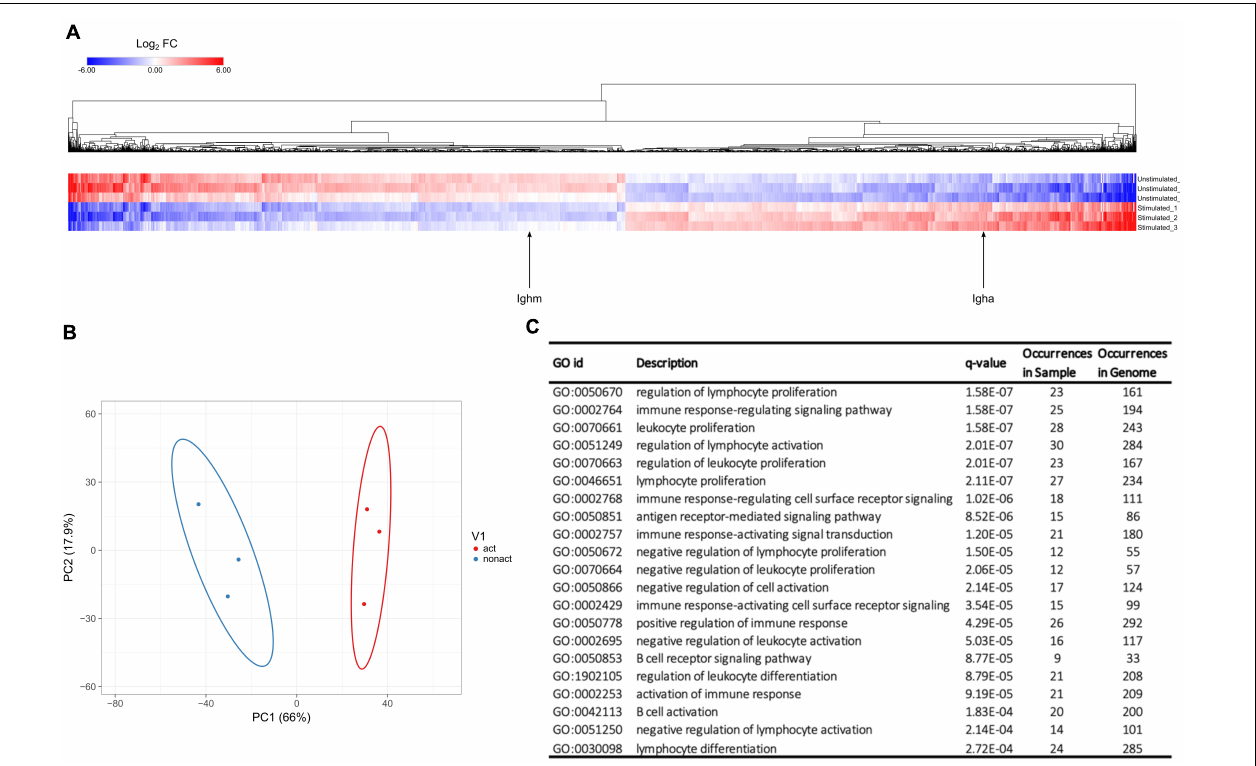
Frontiers in Cell and Developmental Biology |